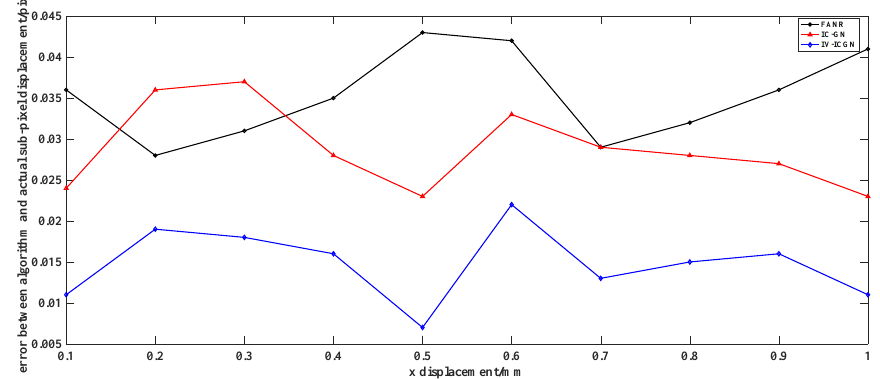
Figure 14. Mean of sub-pixel displacement corresponding to each movement of 0.1